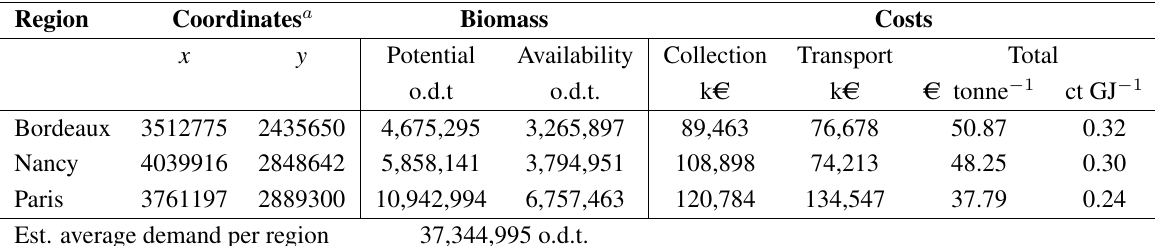
Table 3 . Availability of biomass in three different regions in